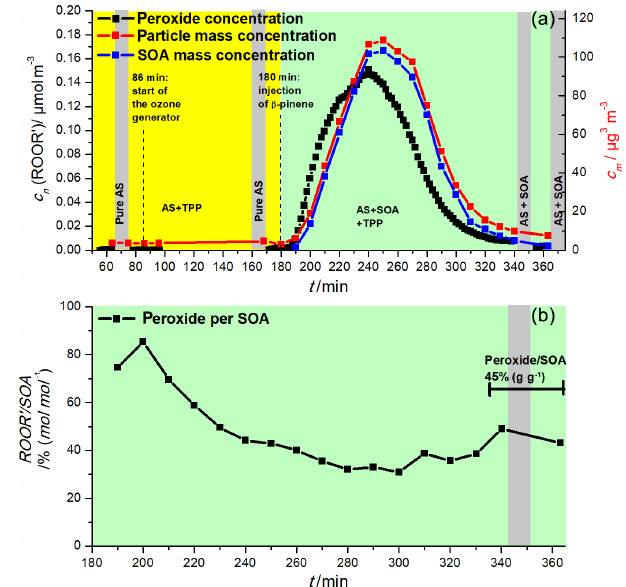
Figure 7. Ozonolysis of β -pinene in the presence of AS aerosol. Time series of (a) peroxide (black), particle mass concentration (red) and SOA mass concentration (blue); (b) relative contribution of peroxide to the amount of SOA. Ozone was added at 86min, β - pinene at 180min. Averages molar masses of 250 and 300gmol − 1 for SOA and peroxides were assumed,